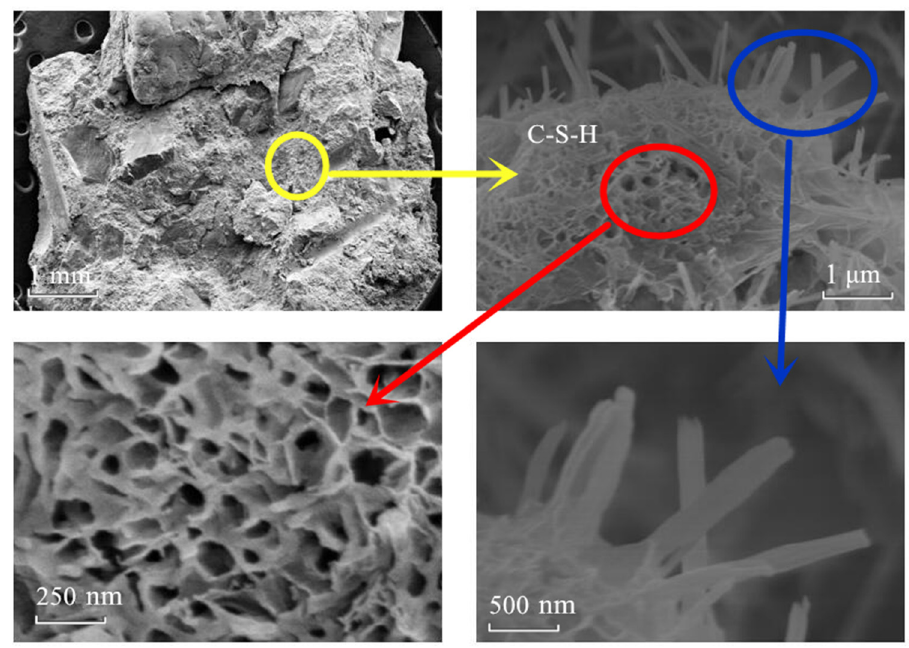
Figure 13: Microstructure of the UHPC with NS at 28 days.